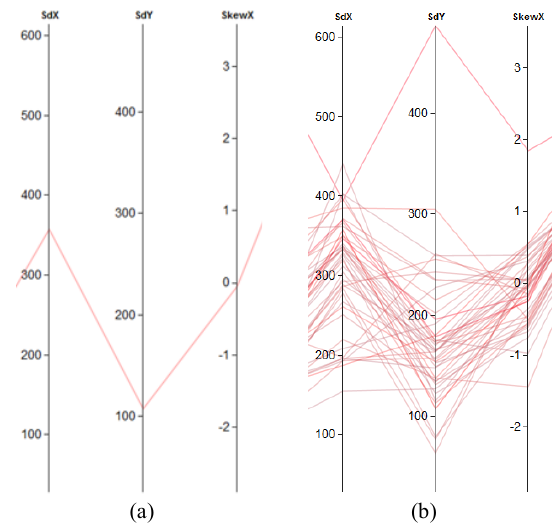
Figure 2. Parallel coordinates for multiple data dimension: (a) polyline plot of one data point and (b) polylines of the multiple data